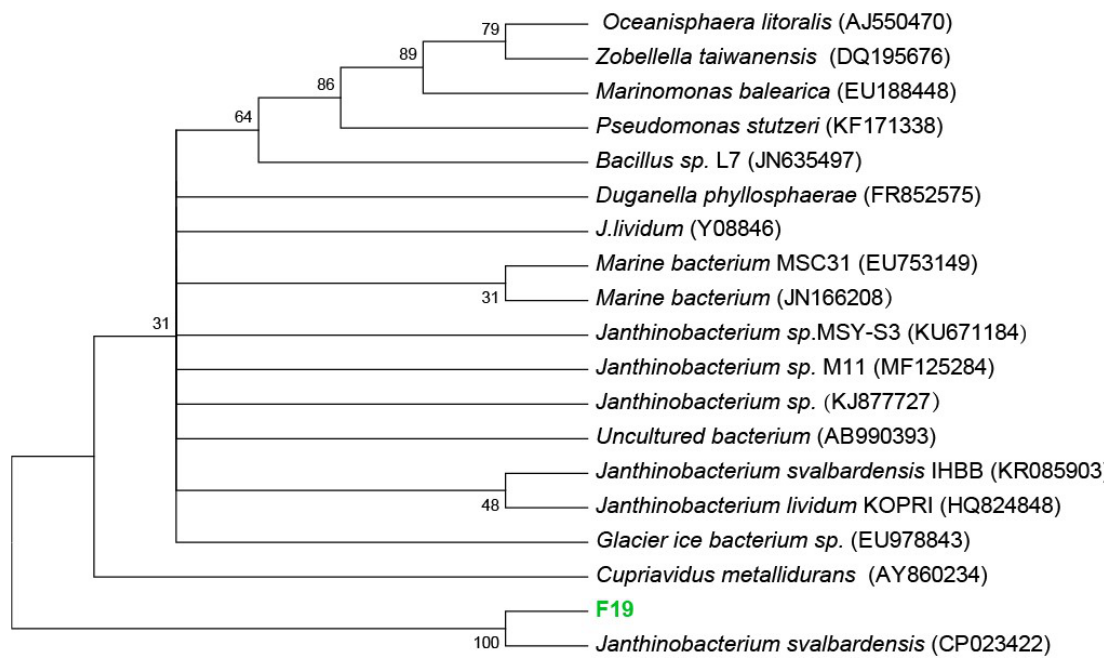
Figure 1. Phylogenetic tree of strain F19 and close relatives based on 16S rDNA gene